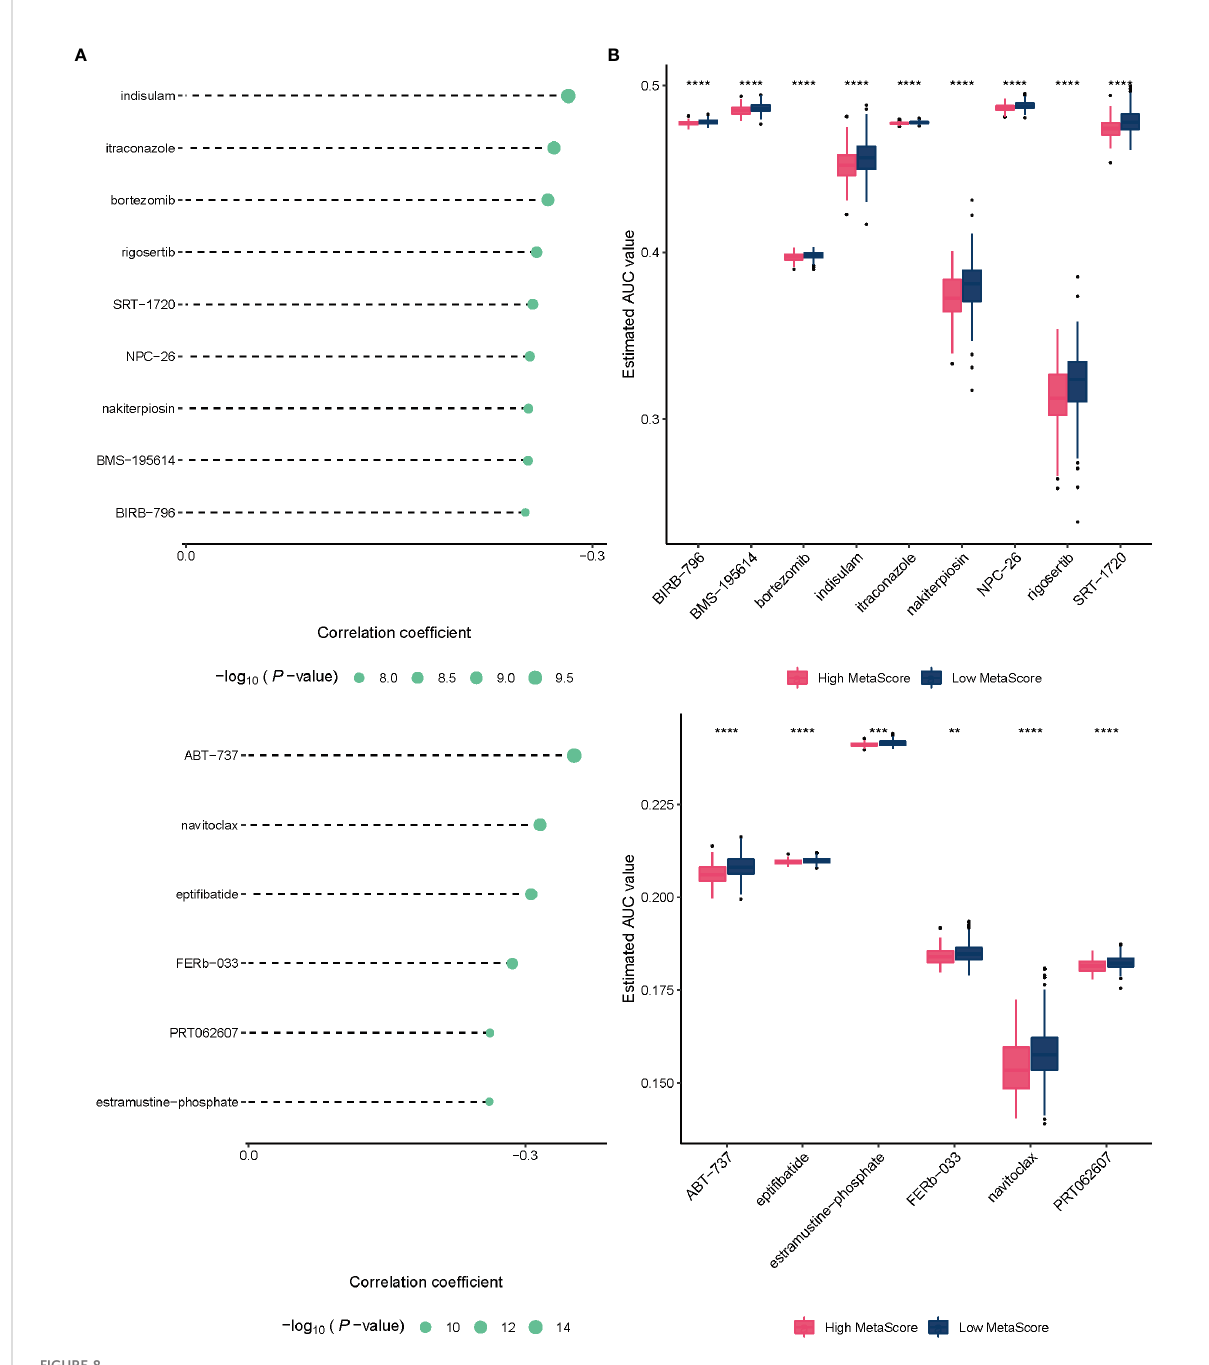
FIGURE 8 (A) The correlation coef fi cient of 15 chemotherapy drugs. (B) The estimated AUC value of 15 chemotherapy drugs between MetaScore groups. **p < 0.01, ***p < 0.001, ****P <